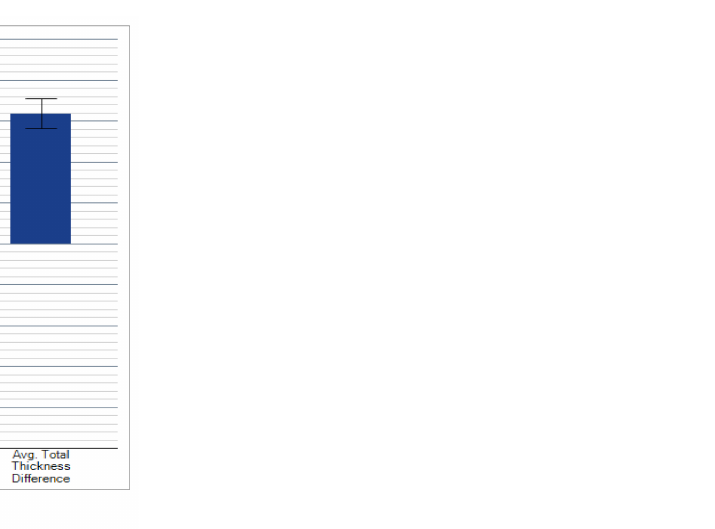
Figure 9. Geomorphic Change Detection (GCD) analysis for ROI 1; ( a ) areal changes; ( b ) volu- metric changes; ( c ) vertical averages. The remaining results of the GCD analysis were placed in the Appendix